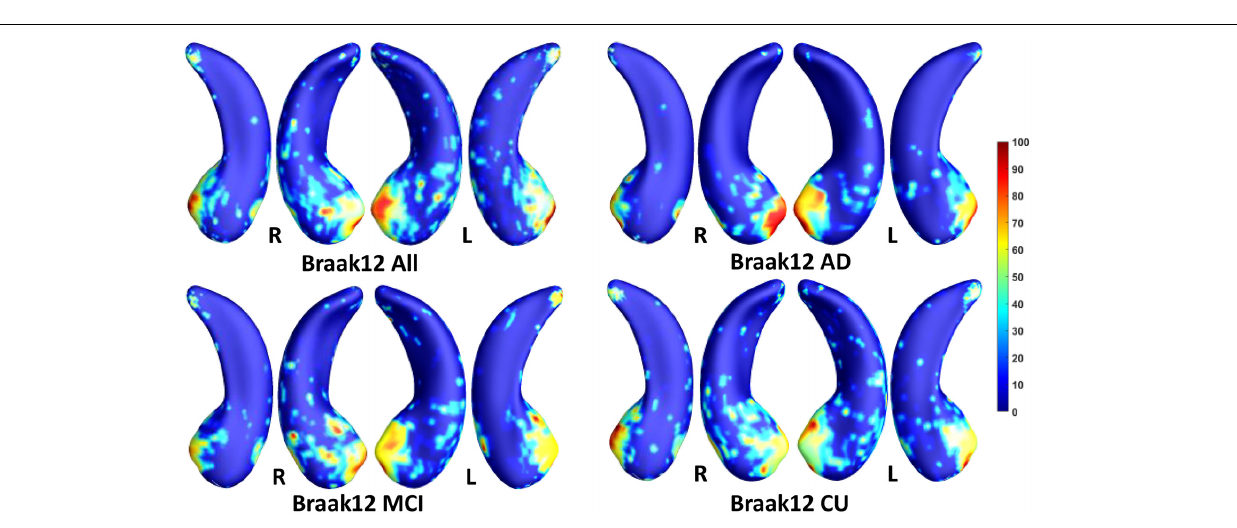
selected ROIs are − 0.37 and − 0.29 and the ones for the